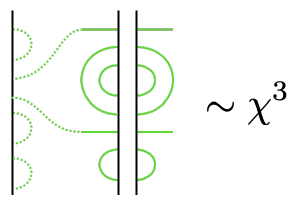
come from the TL diagrams whose right half is a Figure 12 . The leading contributions in M ( m ) k mirror image of the bases in V ( m ) . The contributing power is related to the number of defects by k χ m/ 2 − k . Here m = 8 and k = 1